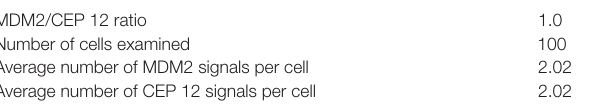
taBLe 2 | Scoring of MDM2 by fluorescence in situ hybridization. MDM2/CEP 12 ratio